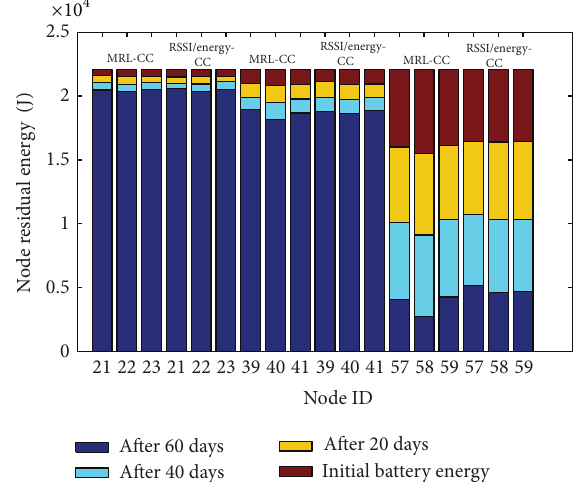
Figure 7: Energy consumption comparison for each selected CN group between MRL-CC algorithm and RSSI/energy-CC algorithm.